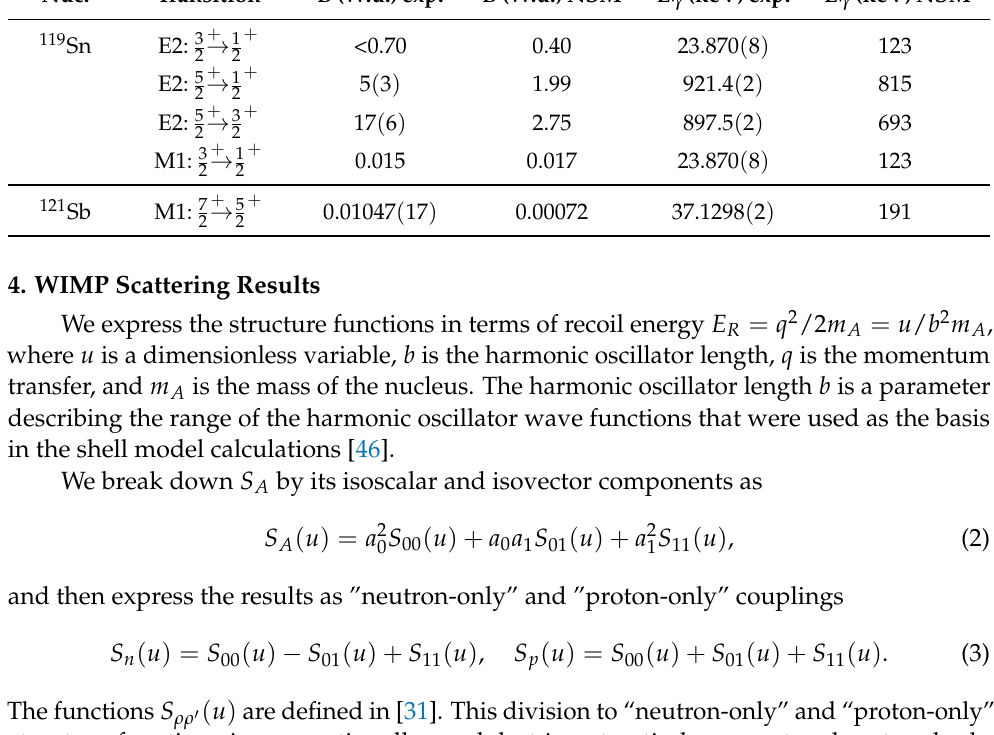
Table 3. Comparison between calculated and experimental nuclear moments in the lowest two states of 119 Sn and 121 Sb. Effective charges and g-factors were e